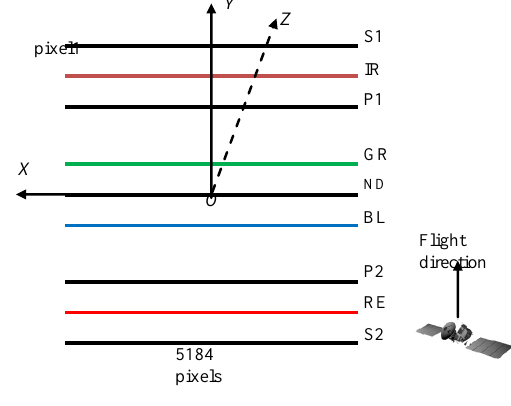
The coordinates of HRSC is defined as follows. The Y axis is parallel to flight direction and the X axis is along the CCD line array which is perpendicular to the Y axis, while the Z axis is perpendicular to focal plane and points to image line direction. The XYZ constitute right hand system.